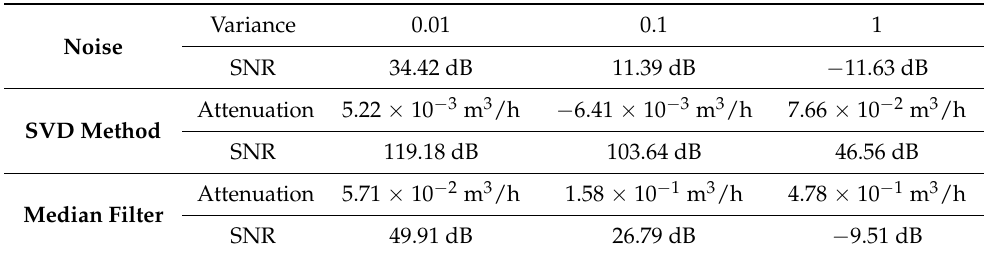
Table 3. Amplitude attenuation and SNR improvement for superposition